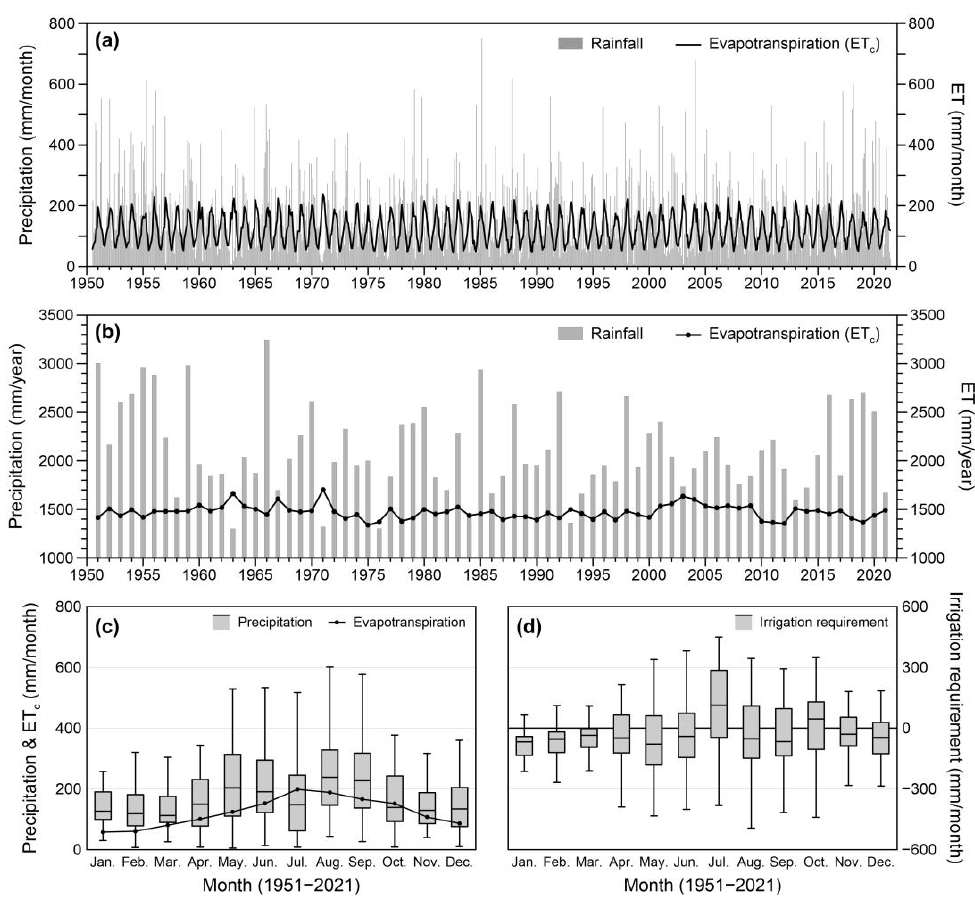
Figure 9. Comparison of precipitation and FAO-56 ET c for the long-term: ( a ) corresponding monthly crop evapotranspiration and precipitation; ( b ) annual rainfall and crop evapotranspiration; ( c ) box chart of monthly precipitation and FAO-56 ET c ; and ( d ) box plot of irrigation water requirement.